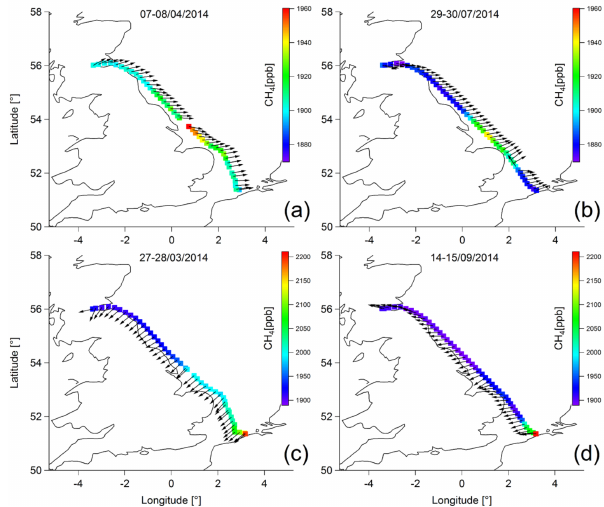
4 mole fractions along the route of the DFDS freight ferry in March, April, July, and August 2014. Arrows denote local wind